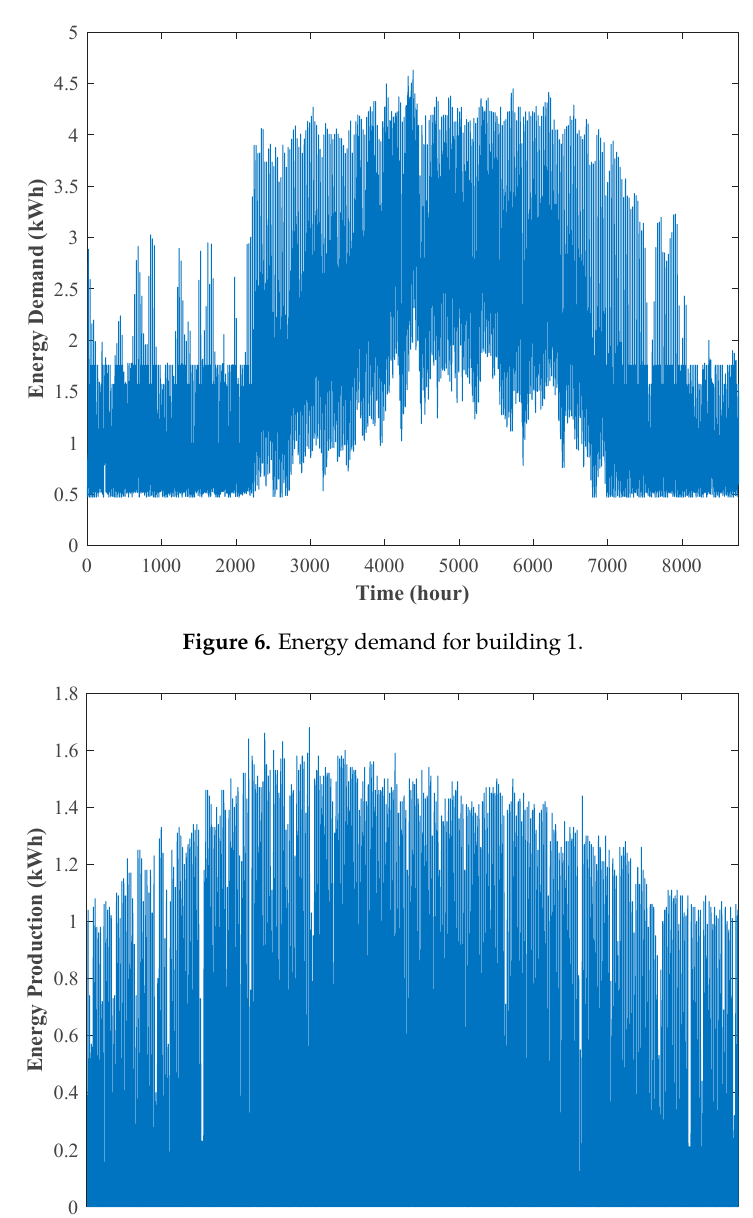
Figure 7. Energy production of 2 kW PV system for building 1.